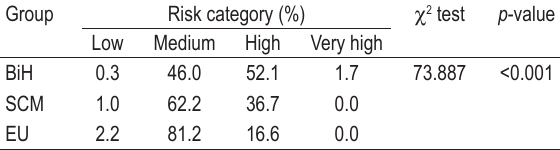
TABLE 3. Classification of occupational risk in the studied groups